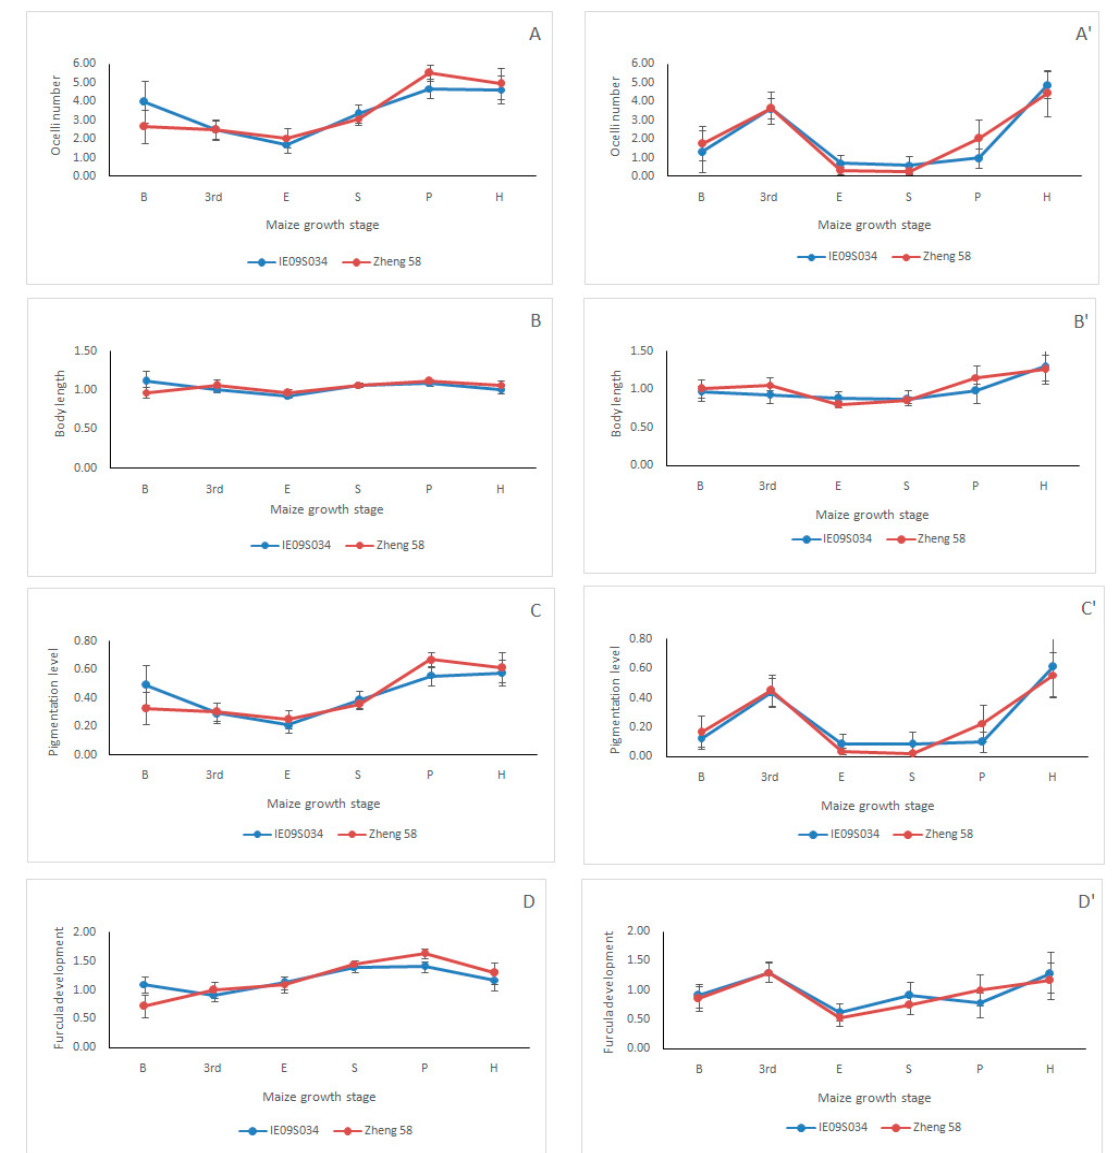
Figure 2. Collembolan morphological trait attribute values (CWM) (mean ± SE) in different maize variety fields (transgenic Bt maizeIE09S034 and its near-isoline of non-Bt maize Zheng 58) in Northeast China in 2014 and 2015. Maize growth stage “B”, “3rd”, “E”, “S”, “P”, and “H” are shorted for “before sowing”, “3rd leaf”, “elongation”, “silking”, “physiological maturity”, and “harvesting”, respectively. ( A ) is the collembolan ocelli number in 2014; ( A' ) is the collembolan ocelli number in 2015; ( B ) is the collembolan body length in 2014; ( B' ) is the collembolan body length in 2015; ( C ) is the collembolan pigmentation level in 2014; ( C' ) is the collembolan pigmentation level in 2015; ( D ) is the collembolan furcula development in 2014; ( D' ) is the collem-bolan furcula development in 2015.